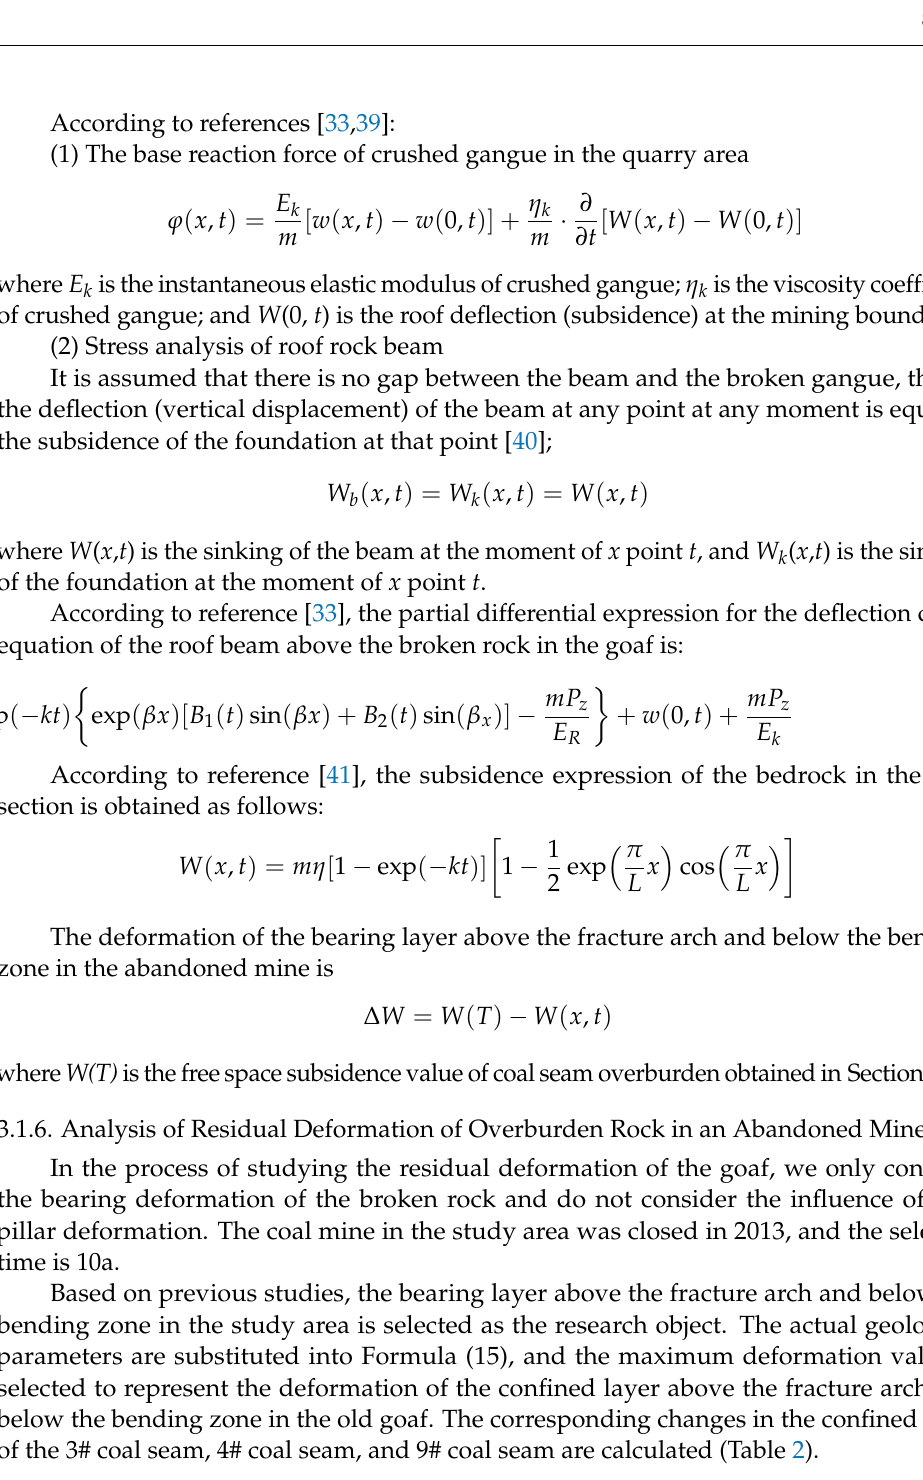
Table 2. Deformation of bearing stratum above the fracture arch and below the bending zone in the abandoned gob. Coal Seam 3# Coal Seam and 4# Coal Seam 9# Coal Seam Residual subsidence volume/m 0.11